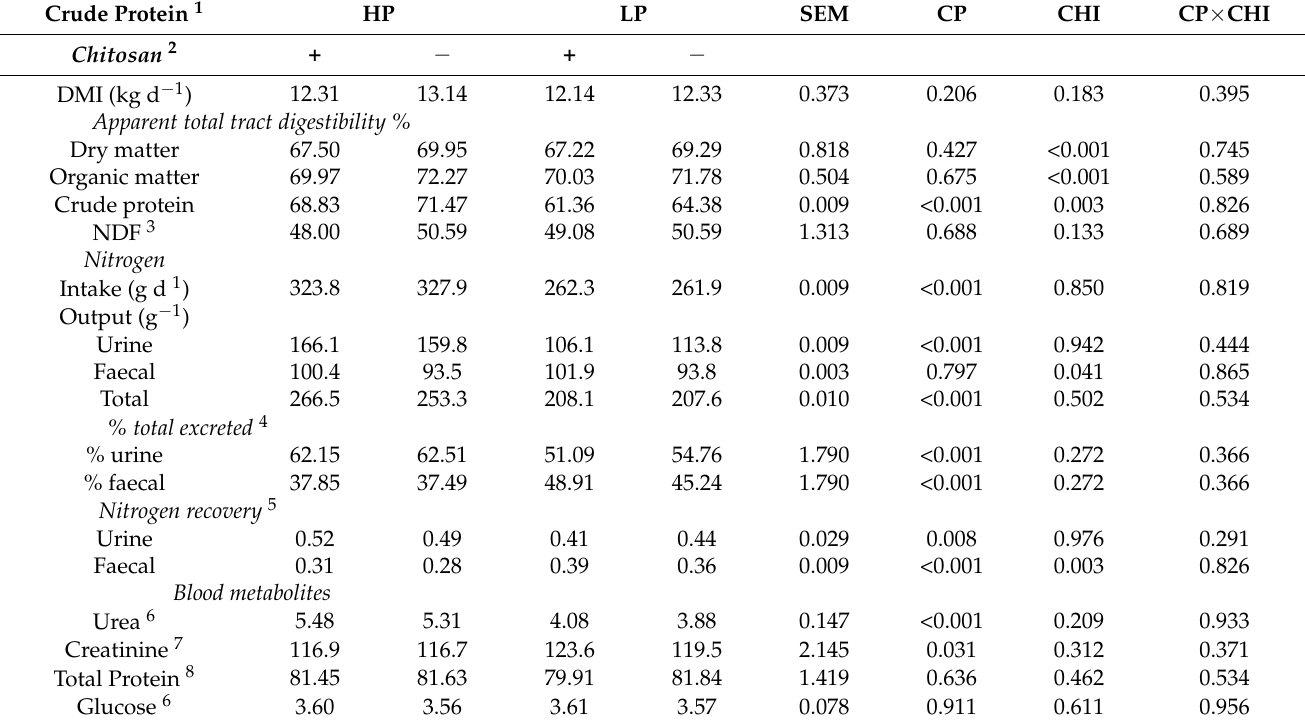
Table 2. Effect of chitosan inclusion and dietary crude protein level on dry matter intake, nutrient digestibility, nitrogen excretion, and blood metabolites in beef heifers offered grass silage-based